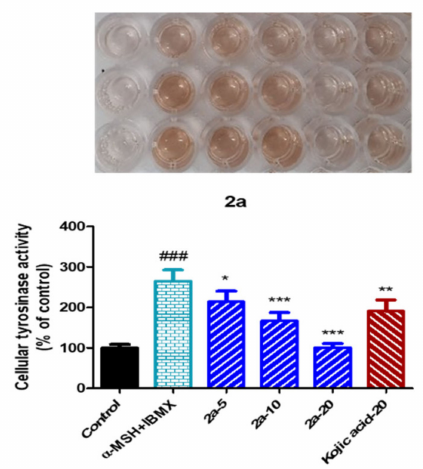
Figure 12. Cellular tyrosinase activity results for 2a on murine B16F10 cells. B16F10 cells were treated with 0, 5, 10, or 20 µ M of 2a for 48 h in the presence of α -MSH (1.0 µ M) and IBMX (200 µ M). Results are expressed as percentages of untreated controls and columns represent the means ± SEMs of three determinations. ### p < 0.001 vs. untreated controls; * p < 0.05, ** p < 0.01, *** p < 0.001, vs. cells treated with α -MSH and IBMX.